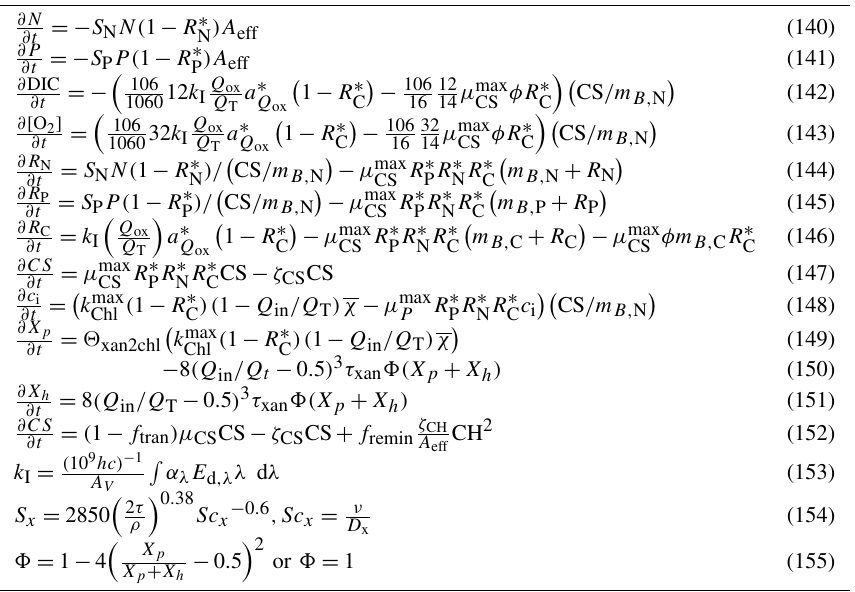
Table 26. Equations for the interactions of coral host, symbiont and environment excluding bleaching loss terms that appear in Table 29. The term CS /m B, N is the concentration of zooxanthellae cells. The equation for organic matter formation gives the stoichiometric constants; 12gCmolC − 1 ; 32gOmolO 2 − 1 .